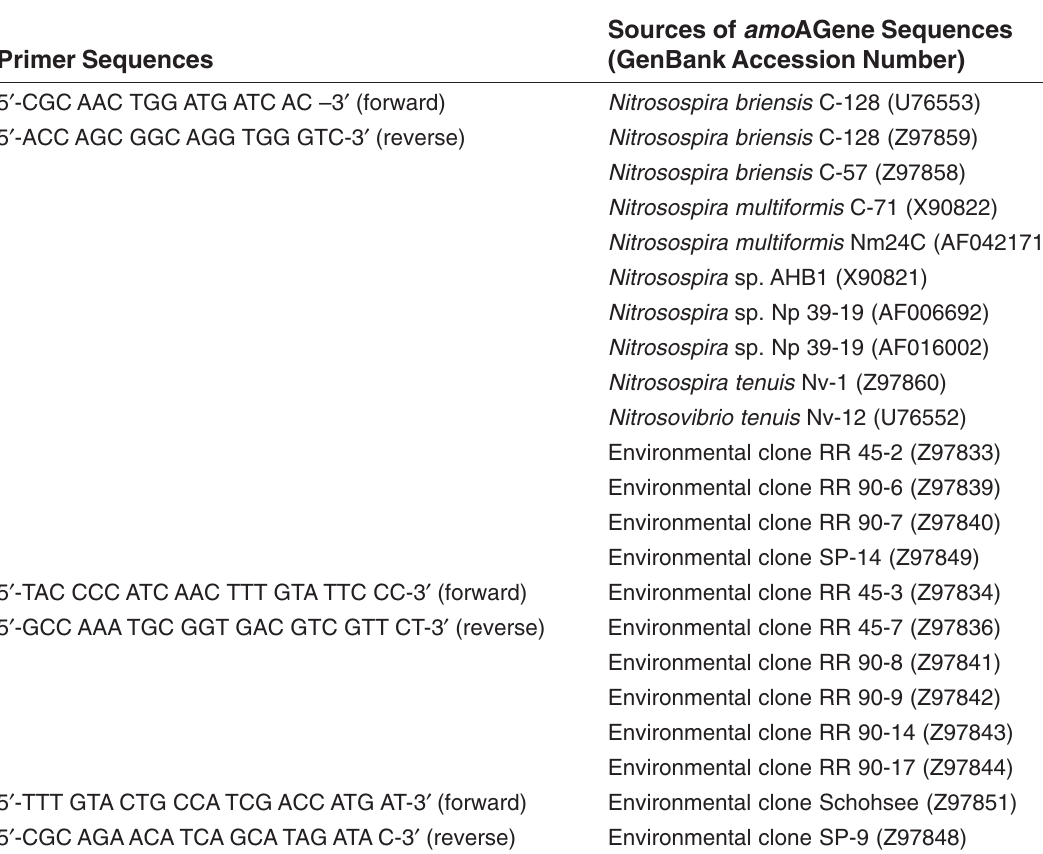
Amplification Primers and the Sources of amoA Genes with Complementary Binding Sites Sources of amoAGene